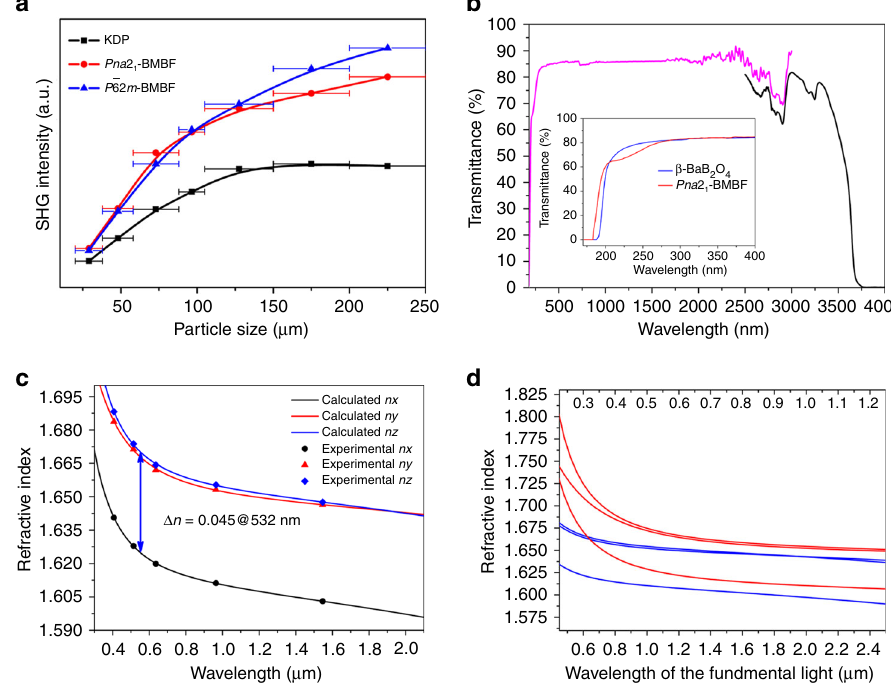
Fig. 4 Optical properties of Pna 2 1 -Ba 3 Mg 3 (BO 3 ) 3 F 3 . a Powder second-harmonic generation data for Ba 3 Mg 3 (BO 3 ) 3 F 3 polymorphs at 1064 nm laser radiation. The well-known NLO material KH 2 PO 4 (KDP) was used as the reference. The curves are drawn to guide the eyes, and are not fi t to the data. The error bars from left to right correspond to sieved crystal particle size ranges: 20 – 38; 38 – 55; 55 – 88; 88 – 105; 105 – 150; 150 – 200; and 200 – 250 μ m. b Transmission spectrum of Pna 2 1 -Ba 3 Mg 3 (BO 3 ) 3 F 3 crystal. Transmittance curve (magenta line) between 180 and 2500 nm was collected by a Shimadzu Solid Spec-3700DUV Spectrophotometer. Transmittance curve (black line) between 2500 and 4000 nm was collected by a Shimadzu IRAf fi nity-1 spectrometer. Inset gives transmittance curves between 170 and 400 nm for Pna 2 1 -Ba 3 Mg 3 (BO 3 ) 3 F 3 (red line) and β -BaB 2 O 4 (blue line). The ultraviolet cutoff edge of Pna 2 1 -Ba 3 Mg 3 (BO 3 ) 3 F 3 is about 184 nm, which is 5 nm shorter than that of β -BBO (189 nm). c The refractive index dispersion curves for the Pna 2 1 -Ba 3 Mg 3 (BO 3 ) 3 F 3 crystal. d The refractive index dispersion curves for fundamental (blue lines) and the second-harmonic (red lines) light. Based